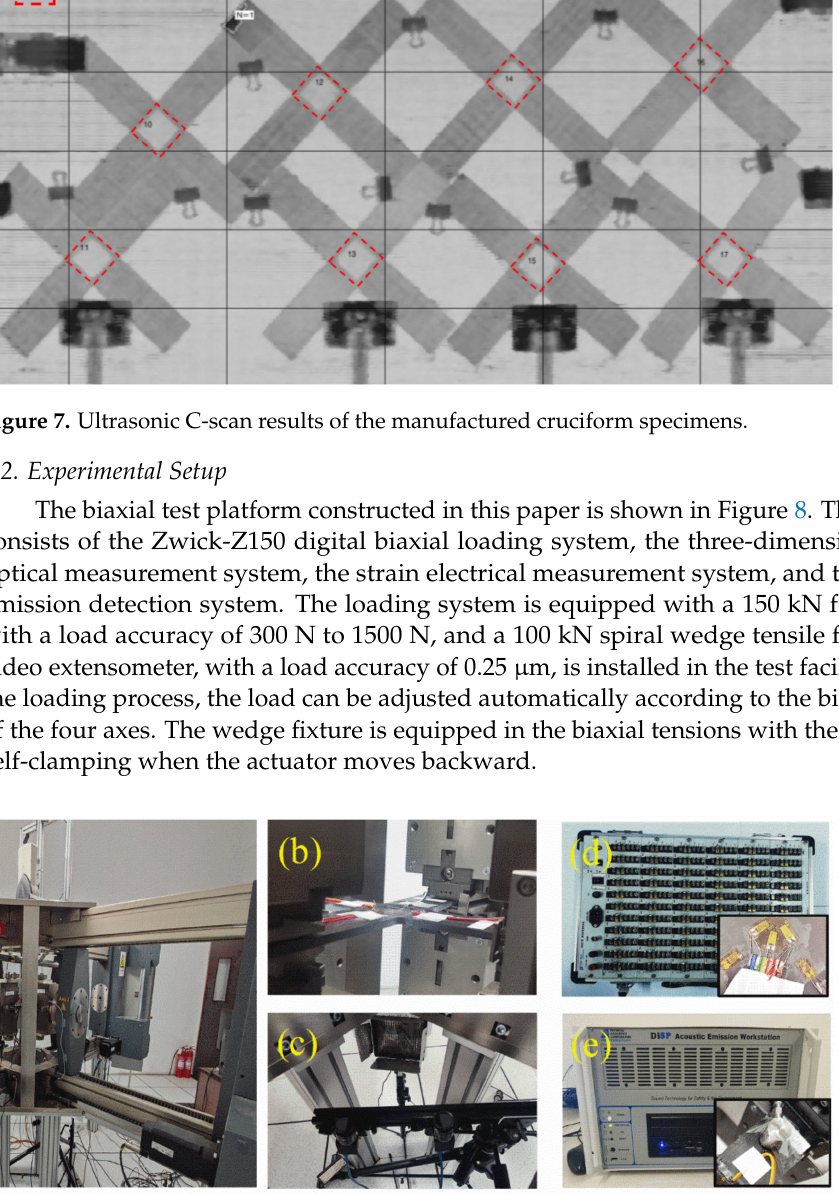
Figure 8. The biaxial test platform. ( a ) Digital biaxial loading system, ( b ) biaxial loading test system, ( c ) three-dimensional strain optical measurement system, ( d ) DH-3820 dynamic strain acquisition system, ( e ) acoustic emission detection